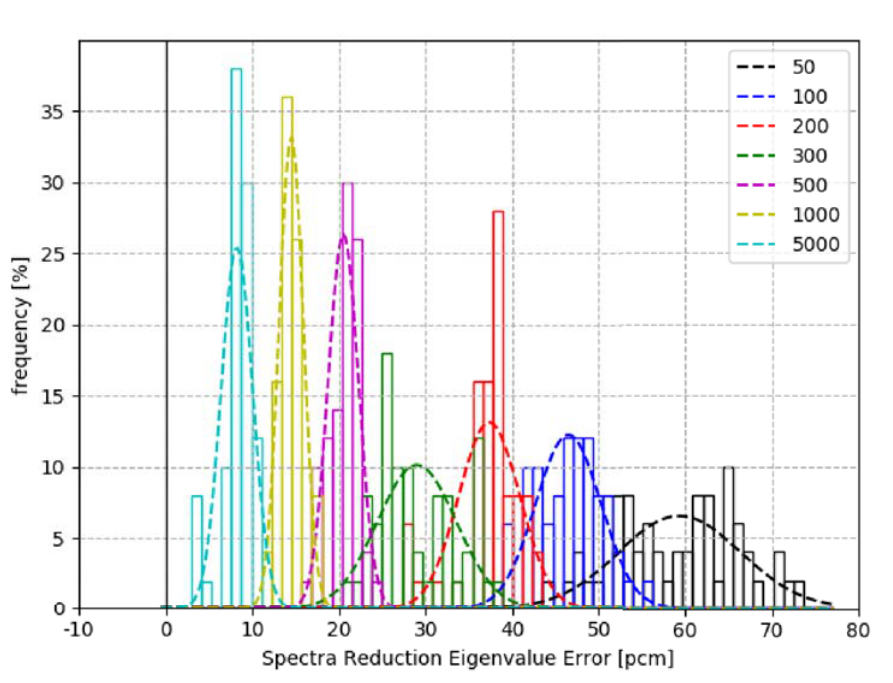
Figure 4: Histogram of eigenvalue error of the k -means algorithm with 50-5,000 clusters using 30 realizations per sample and 50 samples. Dashed lines are normal distributions fit to the data.